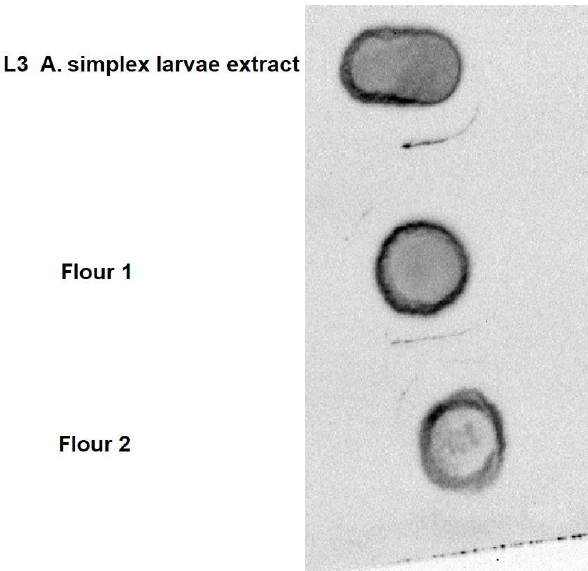
Figure 2. Dot blot analysis of protein extracts from A. simplex L3 larvae and two commercial flours widely used for feeding fish and chicken destined for human